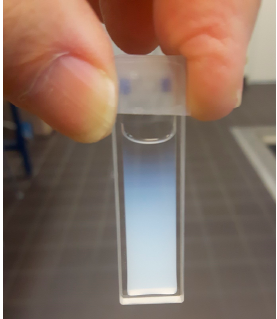
Figure 7. Sedimentation of ZnO (NM110) nanoparticles at c = 2.56 mg/mL and t = 30 h after dispersion in cell culture medium. In the UV-Vis spectrophotometer used for qualitative analysis, the light passes through the suspension as a flat vertical light sheet in the lower third of the cuvette.